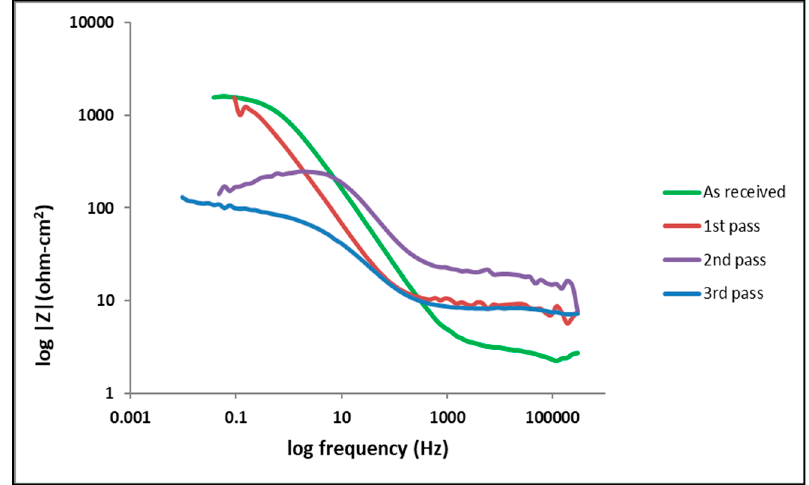
Figure 4. Electrochemical impedance spectroscope (EIS) log ׀ Z ׀ curve of the Al5083 alloy in 3.5% NaCl solution.